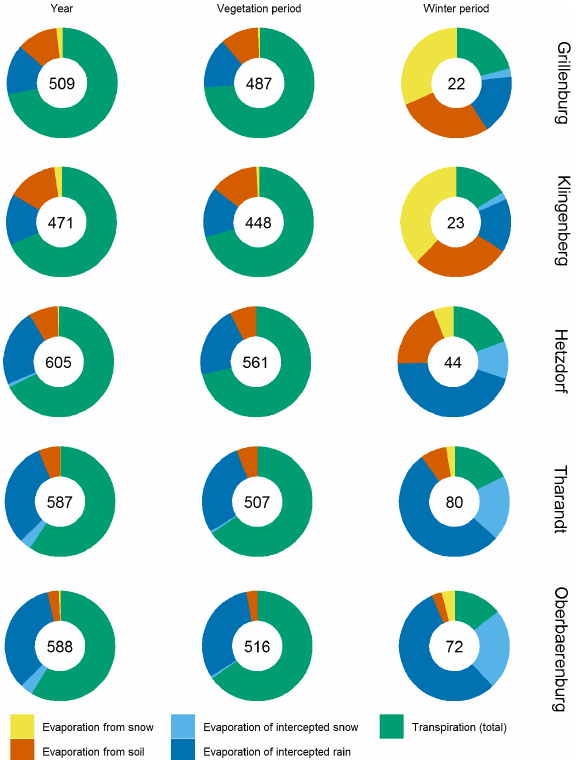
Figure 7. Mean annual and seasonal evaporation components aver- aged over all model setups. The numbers inside pie charts refer to the mean evaporation sums per year or